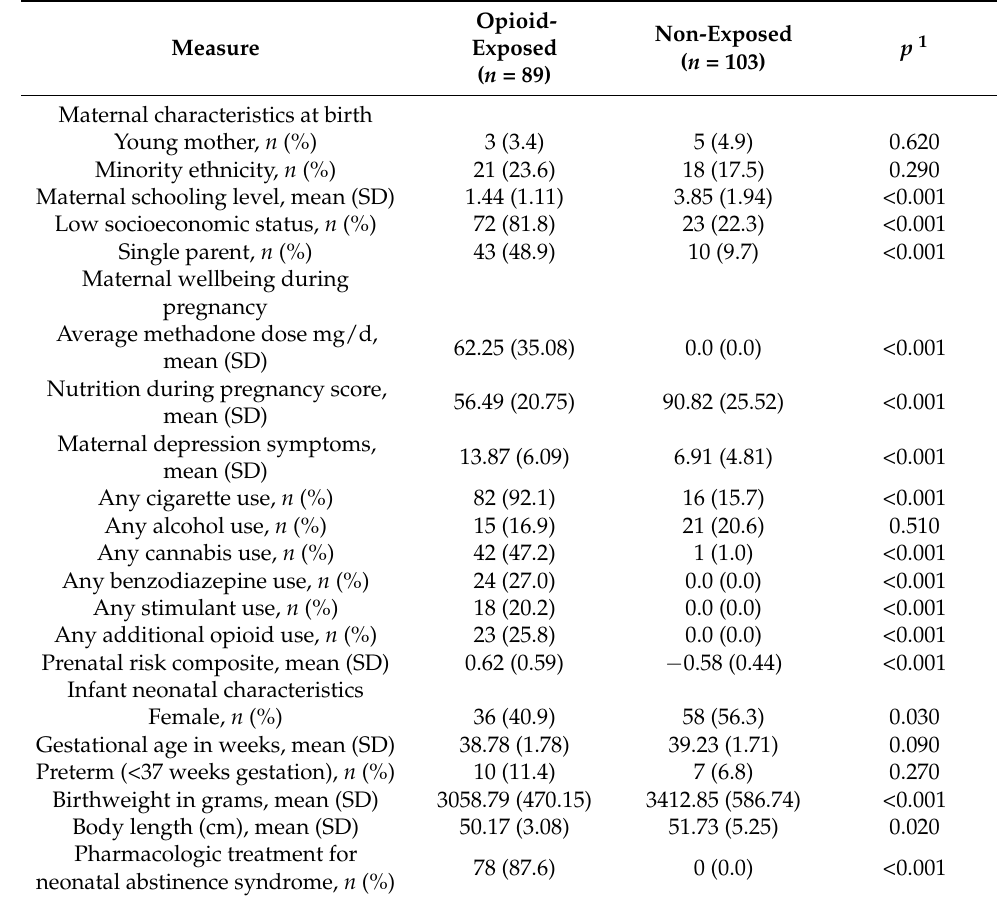
Figure 2. Participant recruitment and retention from birth to 4.5 years. n = number of participants. Table 1. Maternal and infant characteristics.